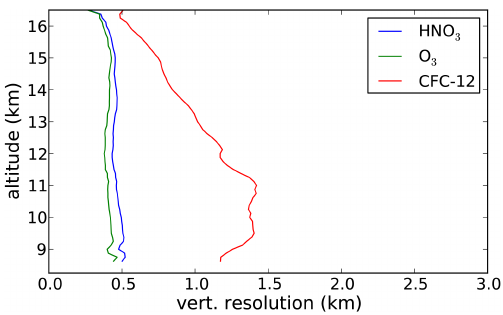
Figure 12. Vertical resolution for HNO 3 , O 3 , and CFC-12, for GLORIA Image